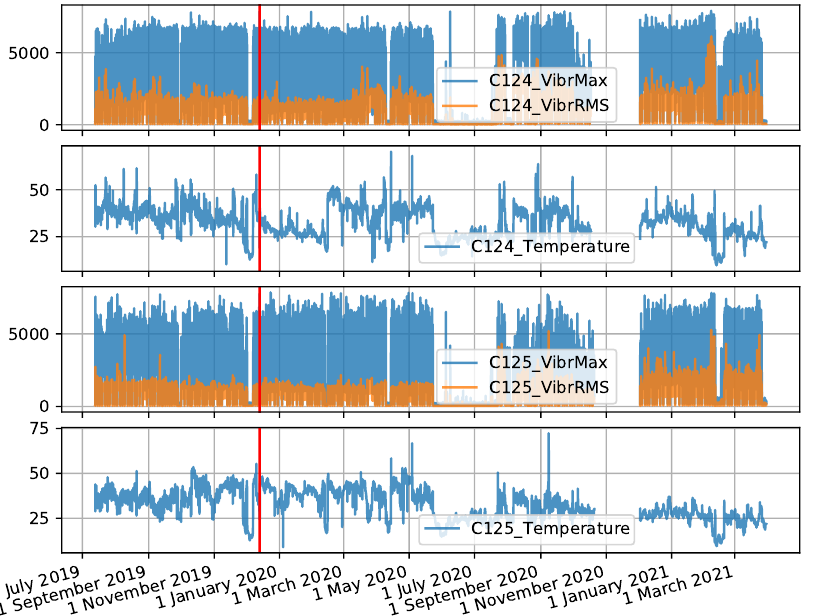
Figure A3. Time series for the NW-20 crusher collected by two sensors (the red colour indicates the locations of